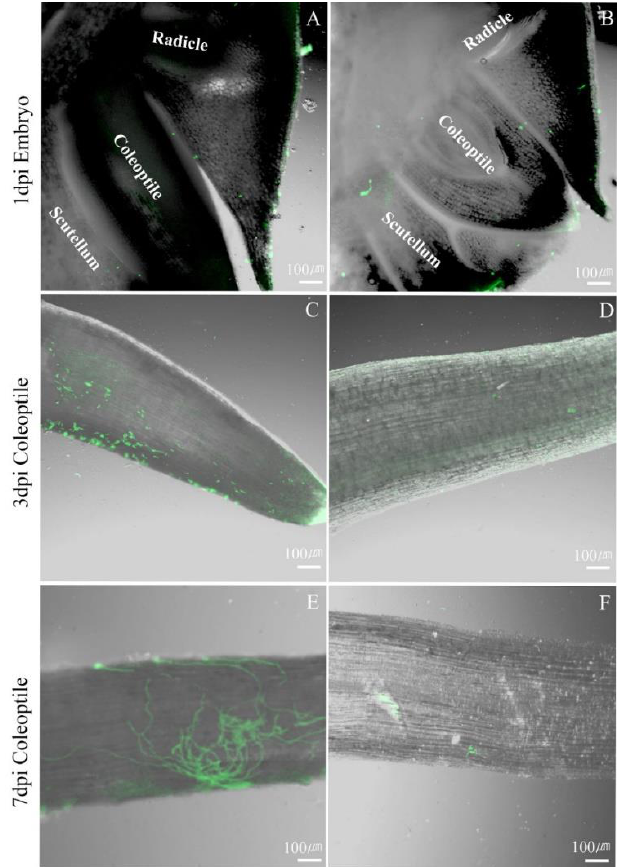
Figure 4. Confocal imaging of Ilpum and Tung Ting Wan Hien1 rice inoculated with CF283-GFP Fusarium fujikuroi isolate. ( A , B ) longitudinal sections of embryos of Ilpum (susceptible) and Tung Ting Wan Hien1 (resistant) cultivars at 1 dpi, ( C , D ) 3 dpi in coleoptile, and ( E , F ) 7 dpi in